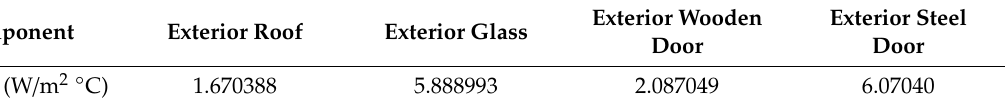
Table A2. Construction components of the house.